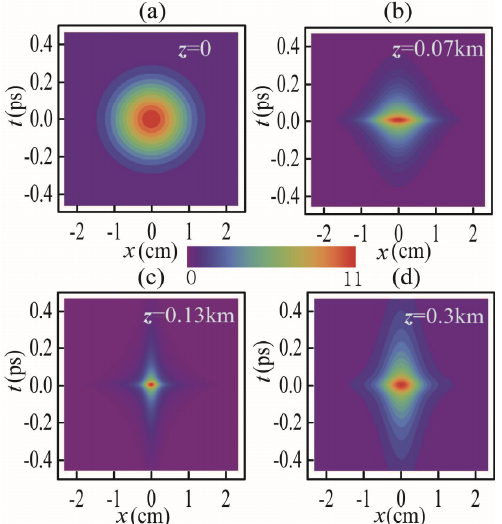
Figure 7. Contour graph of normalized spatial-temporal intensity distribution I ( x , t , z ) of PCP beams with rect weight function at z plane with different values of z : ( a ) z = 0, ( b ) z = 0.07 km, ( c ) z = 0.13 km and ( d ) z = 0.3 km in the x - t plane.